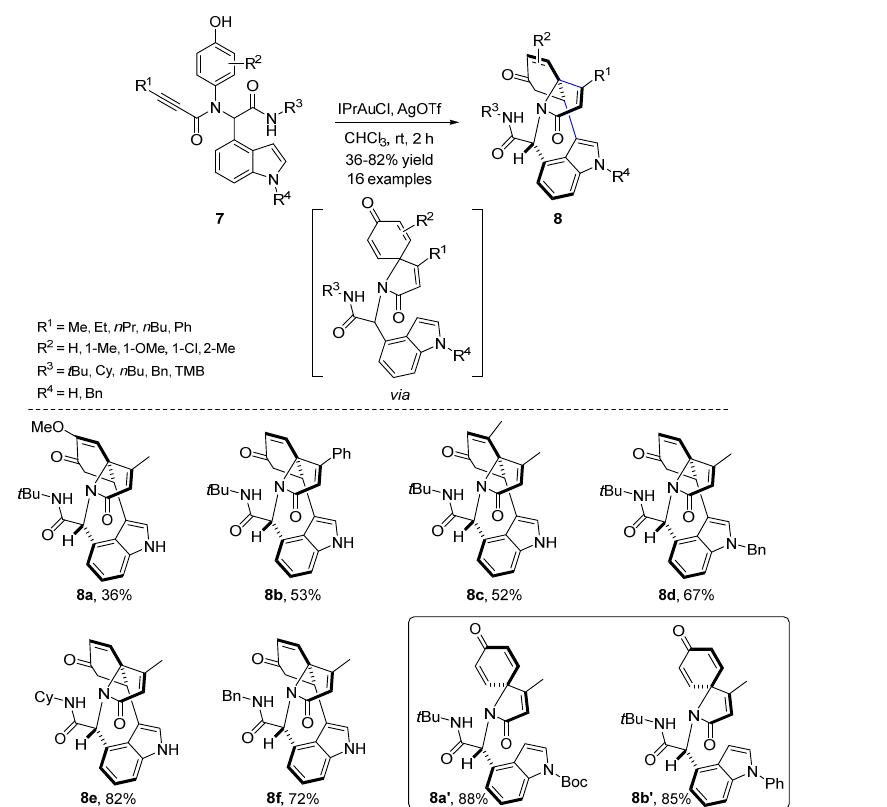
Scheme 5. Gold ‐ catalyzed post ‐ Ugi dearomatization/Michael addition.